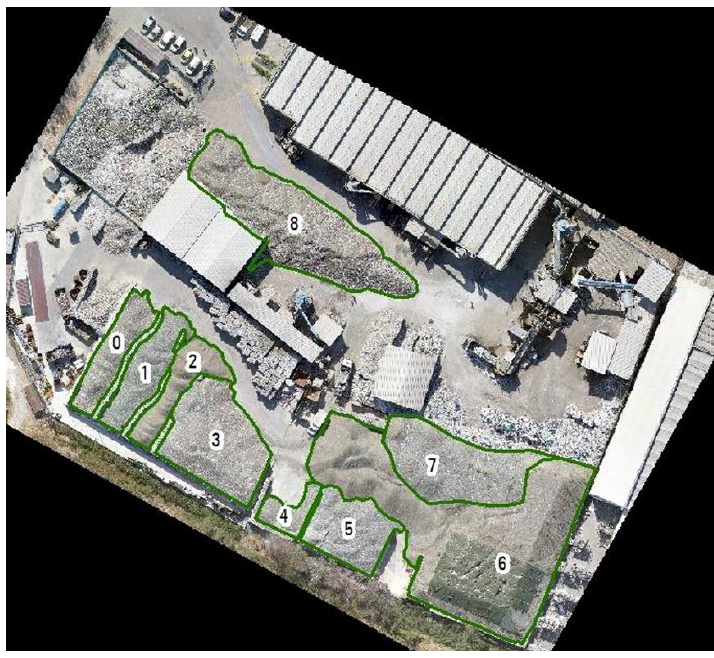
Figure 19. The delimitation of the piles.